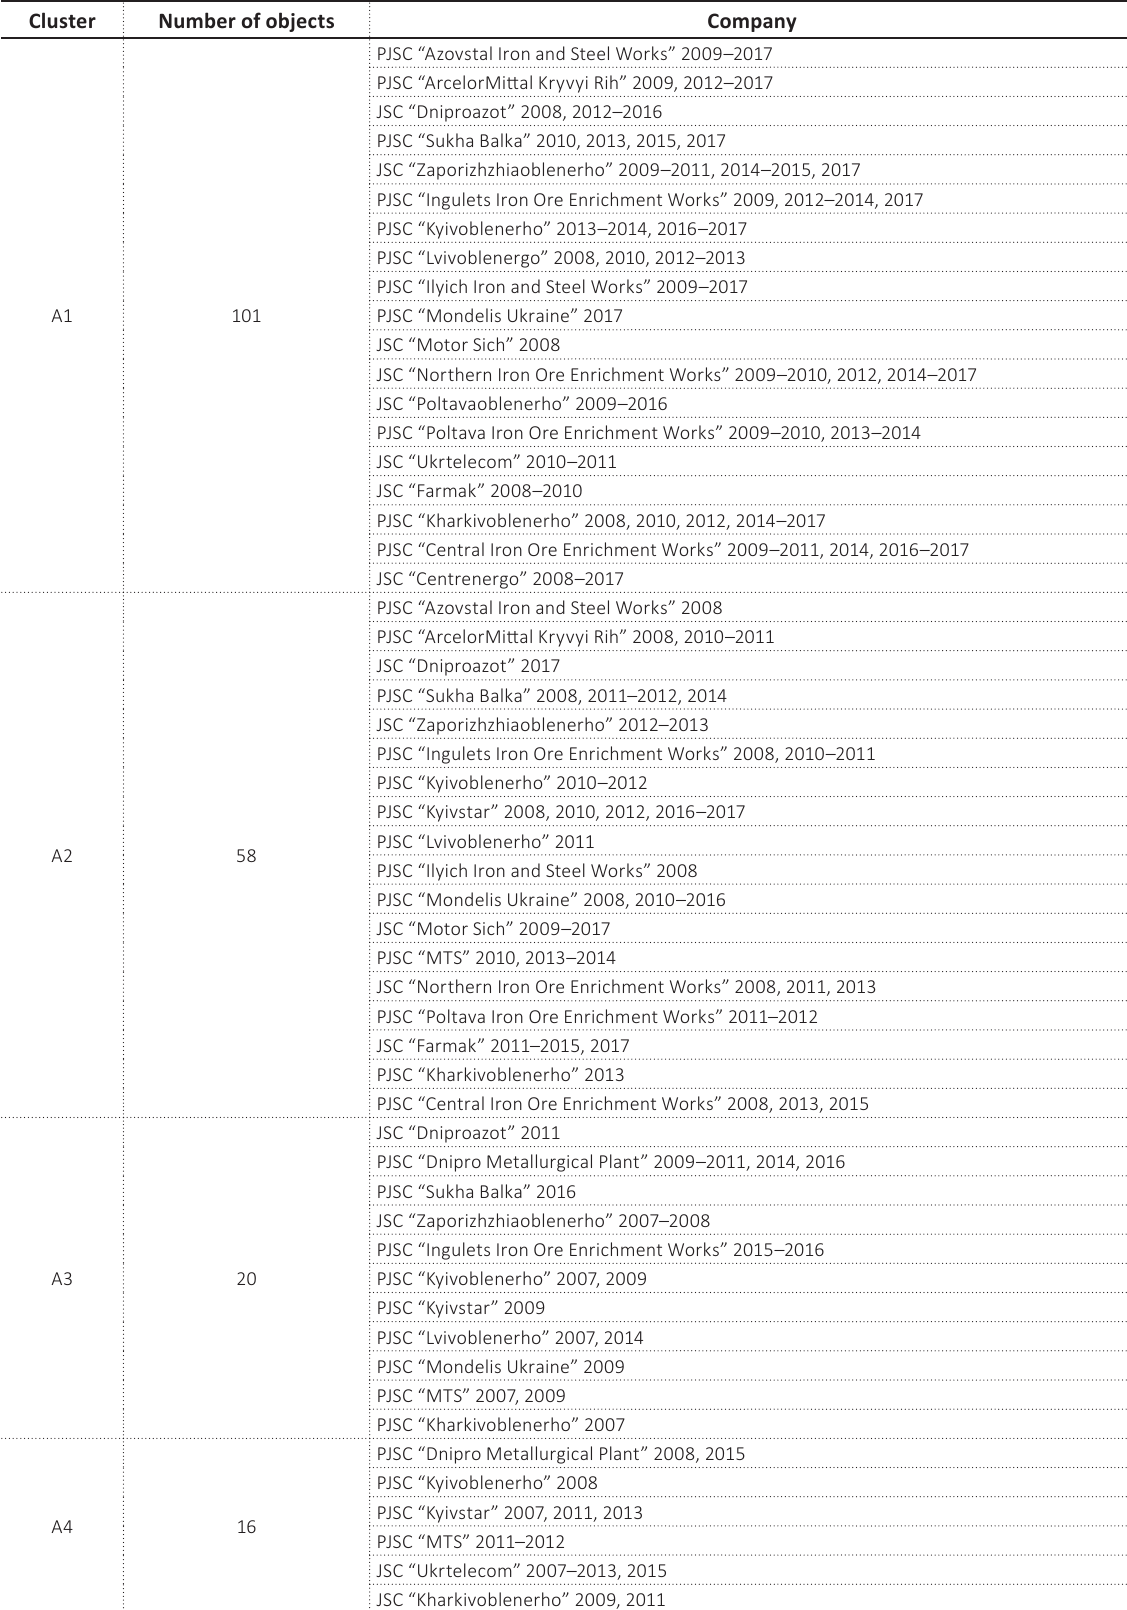
Table 4. General characteristics of clusters